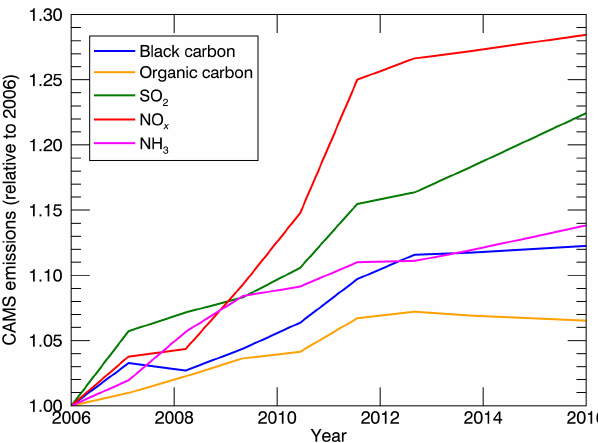
Figure 5. Emissions of aerosols and precursor gases from the Copernicus Atmosphere Monitoring Service. The emissions have been aggregated to annual totals over the southern China study area and plotted relative to the year